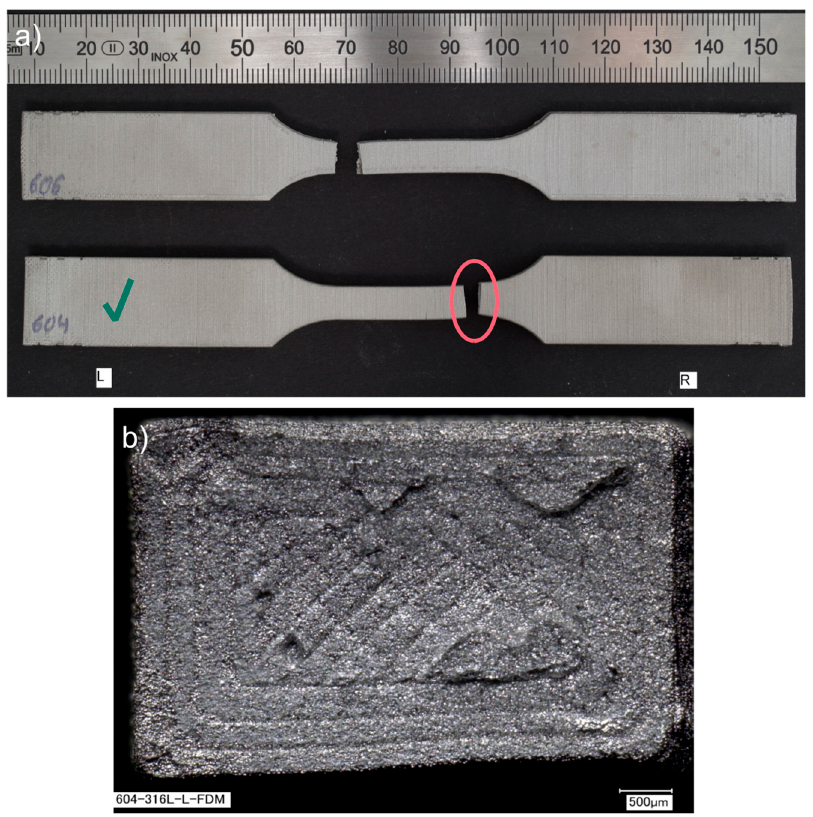
Figure 13. Fatigue fractures of BASF Ultrafuse 316L samples presented as: ( a ) fractured specimens during the fatigue test; ( b ) fracture surface (SEM image), left side, specimen 604, at 44,058 cycles. The samples have been numbered, which are visible in the figure. The letters L and R stand for the left-hand and right-hand sides of the sample in the figure. A green check mark means the specimen whose fracture faces were shown.